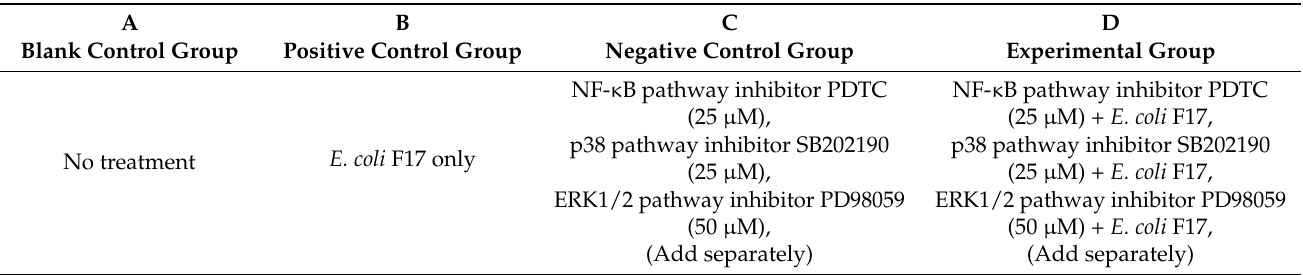
Table 1. Different treatment of